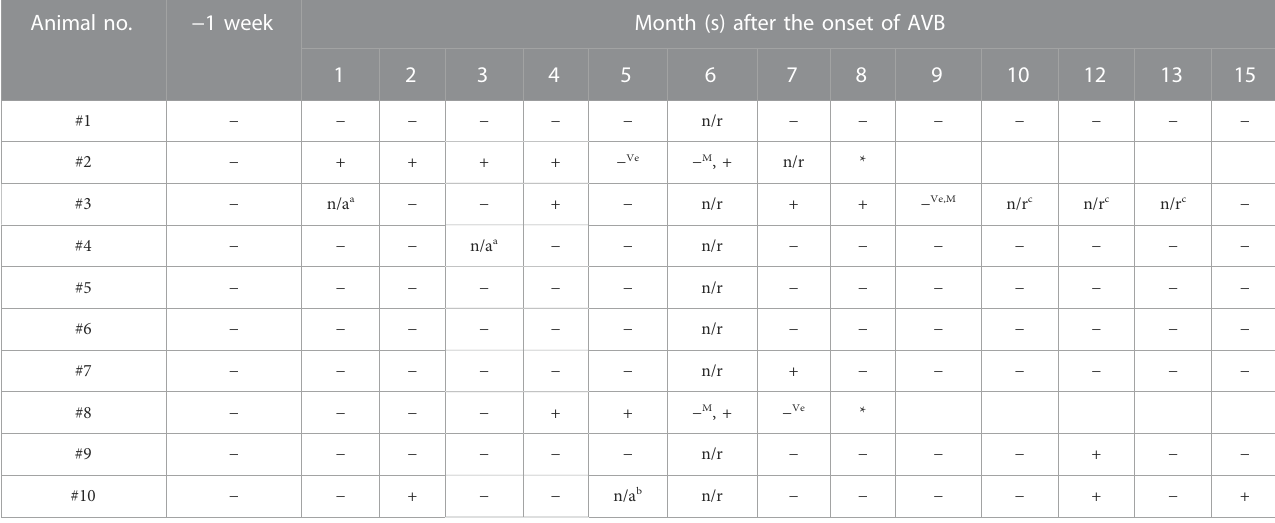
TABLE 2 Time courses of the onset of torsade de pointes (TdP) in the atrioventricular block (AVB) monkey after oral administration of dl -sotalol hydrochloride (10 mg/kg). Animal no.